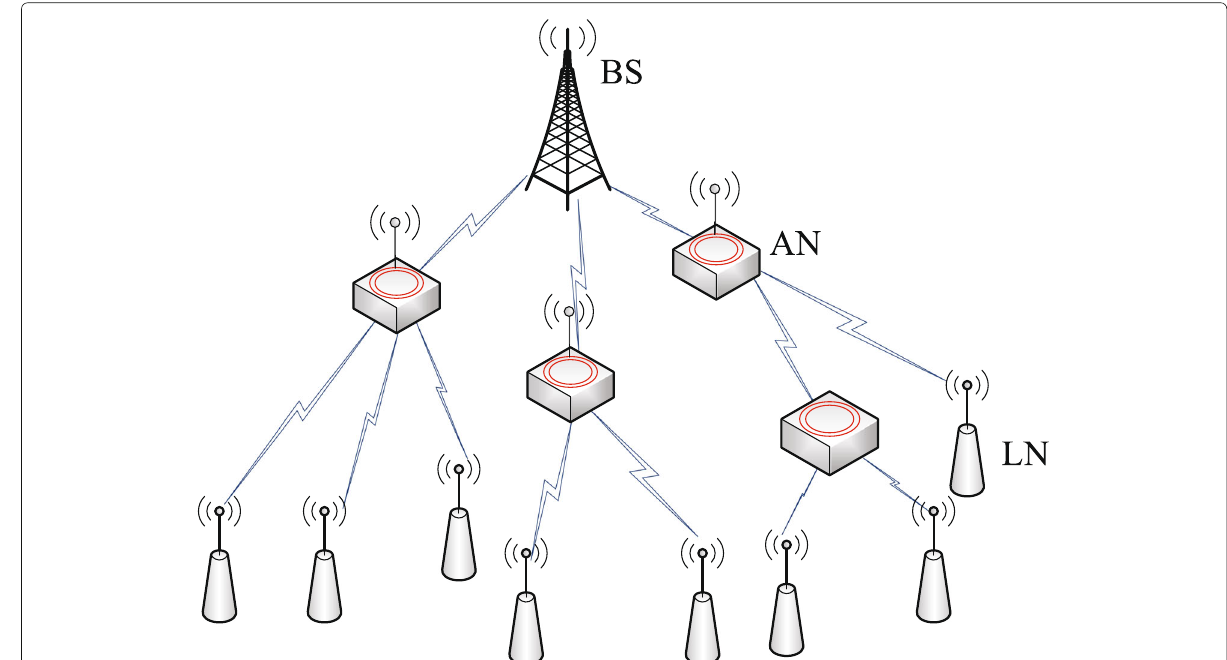
Fig. 4 Aggregation